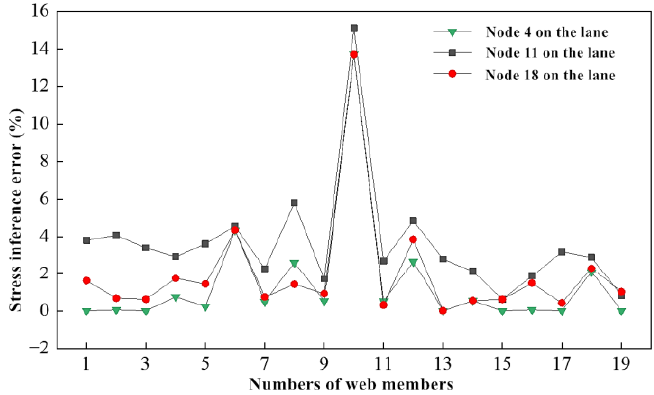
Figure 10. Damage detection results under 9% damage condition. Table 2. Damage detection results with the load applied on node 11.